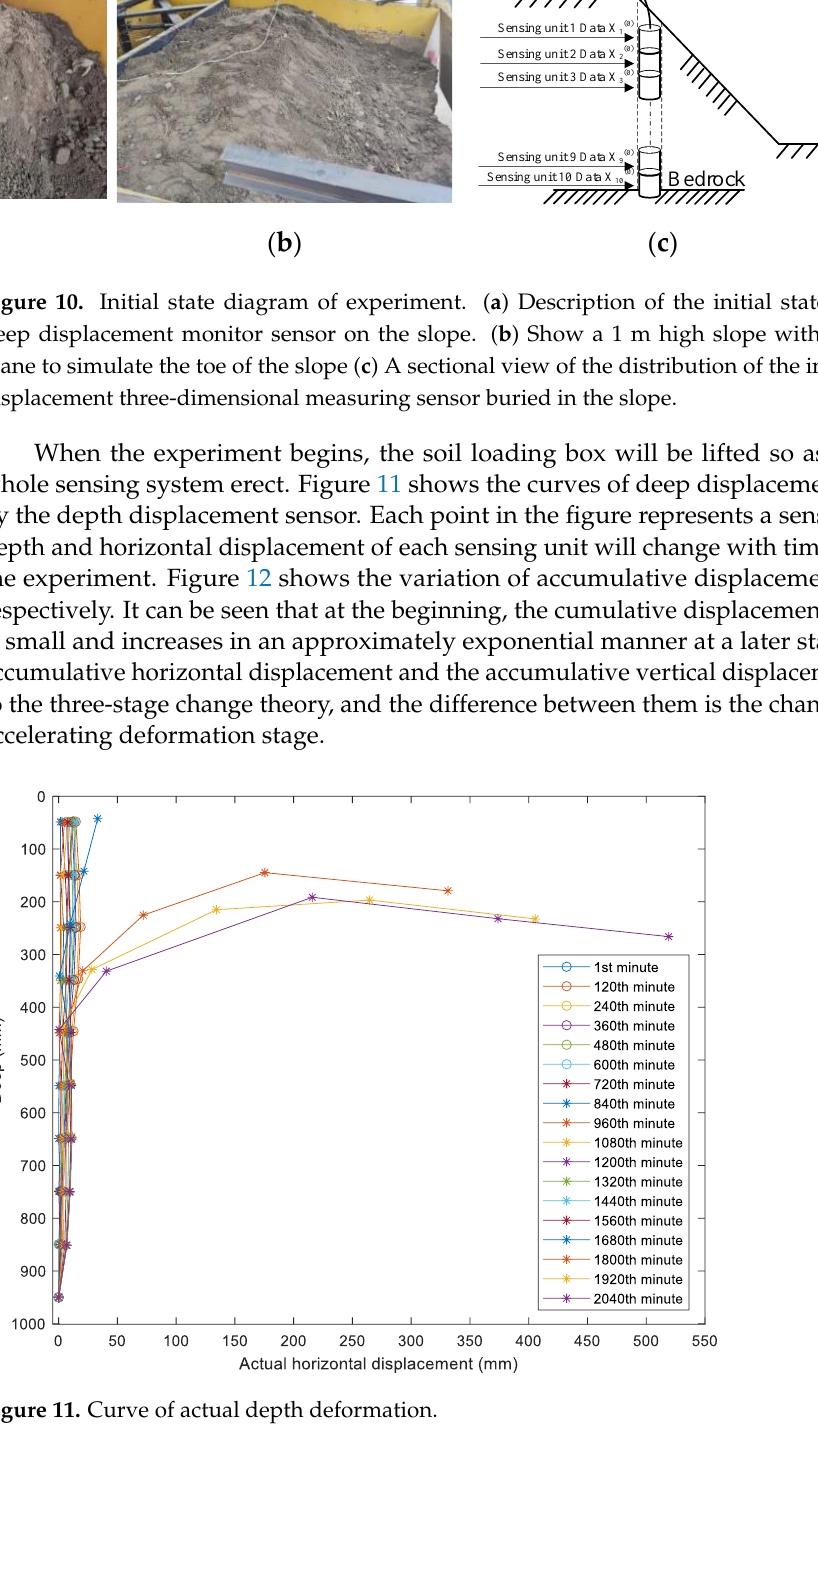
Figure 10. Initial state diagram of experiment. ( a ) Description of the initial state of the entire deep displacement monitor sensor on the slope. ( b ) Show a 1 m high slope with a 20 cm high plane to